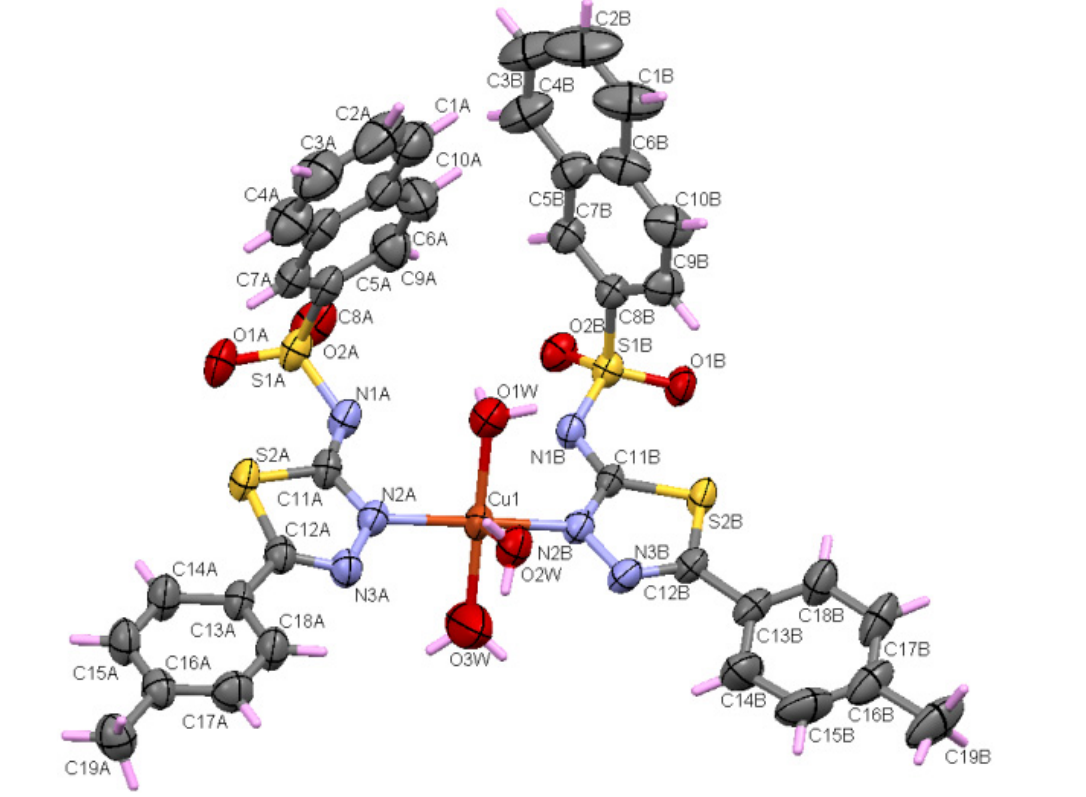
Figure 1. Asymmetric unit of the complex C1 displaying the atoms as thermal ellipsoids at the 50% probability level.